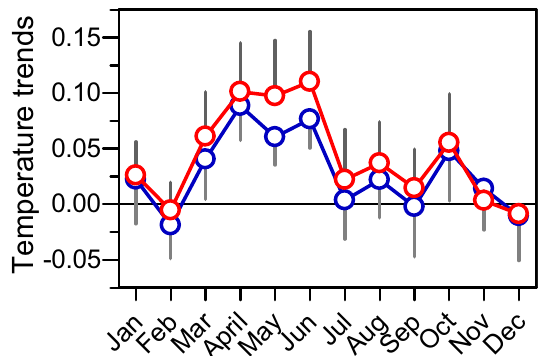
Figure 1. Linear trends in monthly maximum (red circle ± 95% CI) and minimum (blue circle ± 95% CI) temperatures for Mont Aigoual station over 1980–2014 (°C year −1 ). Significant trends were observed in April, May and